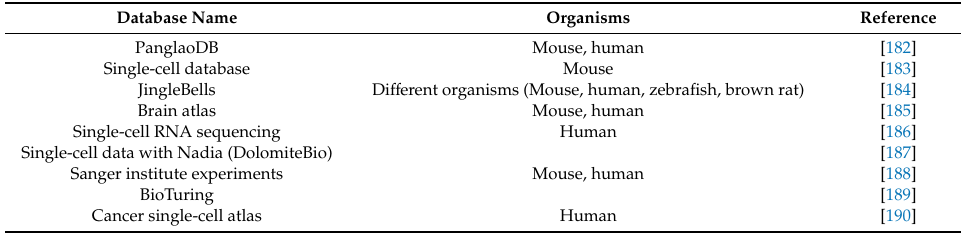
Table 2. List of databases storing single-cell